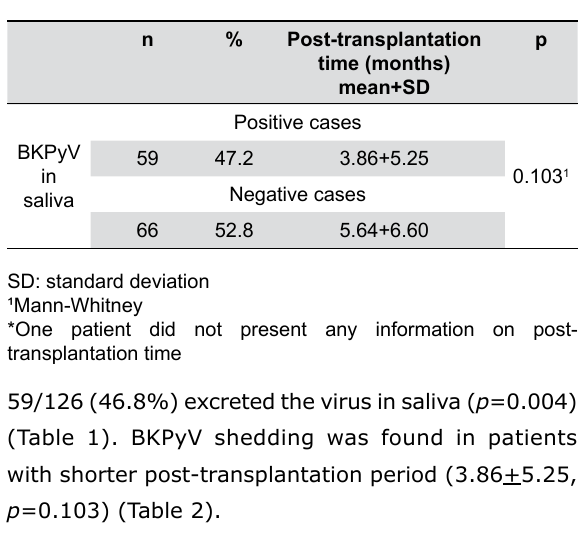
(Table 1). BKPyV shedding was found in patients with shorter post-transplantation period (3.86+5.25, p =0.103) (Table 2).